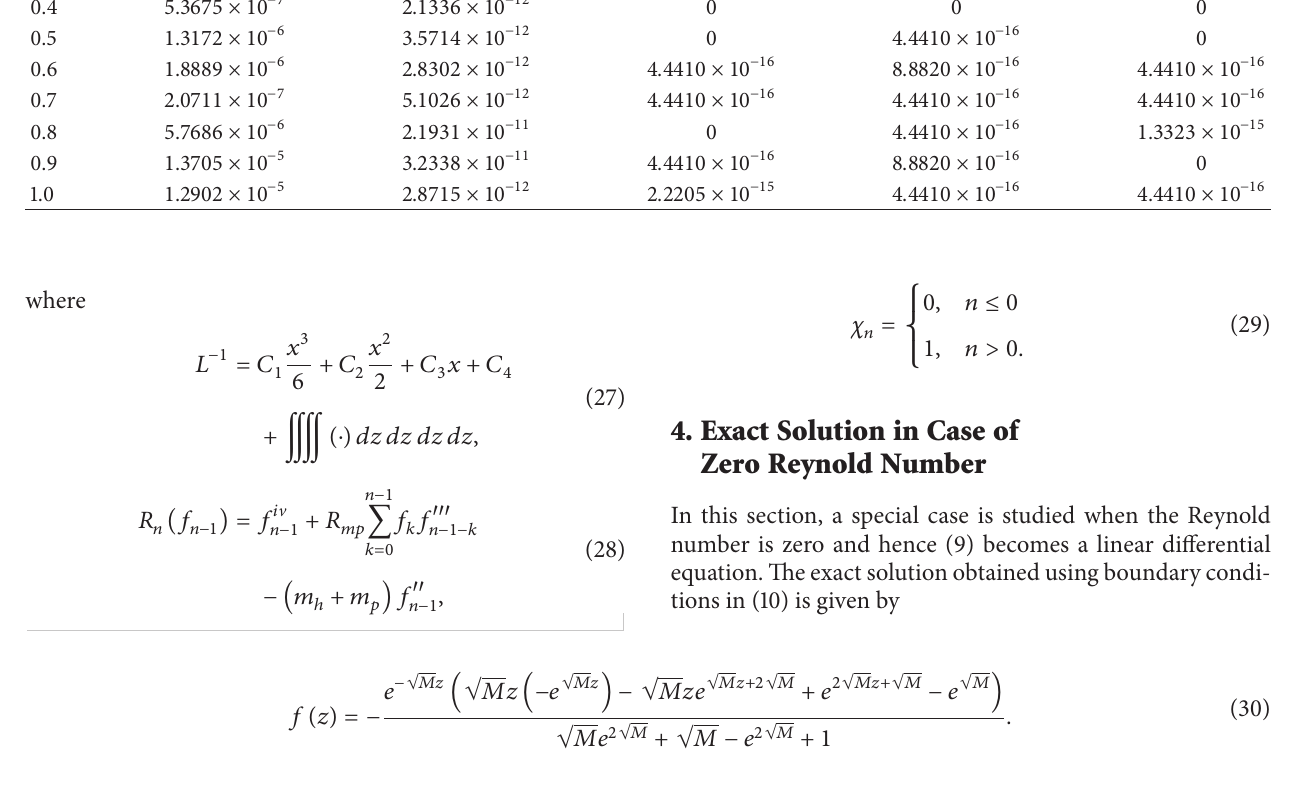
solutions in Figure 1. The curve 𝑓 󸀠 (0) versus ℎ is said to be ℎ - curve . From Figure 1, it is observed that 𝑅 ℎ increases with the increase of approximation order. For fifth-order solution, the valid region for ℎ is −1.6 ≤ ℎ ≤ −0.3 . It is obvious from Figure 2 that when 𝑚 ℎ , 𝑚 𝑝 increase further, the valid region moves towards the right. Figures 3 and 4 are constructed to examine 𝑅 ℎ for increasing 𝑚 ℎ , 𝑚 𝑝 , and 𝑅 𝑚𝑝